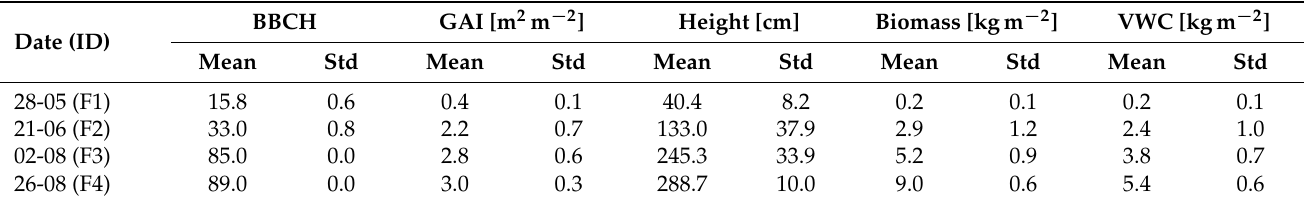
Figure 4. Time series of BBCH, volumetric surface soil moisture, and green area index (GAI) measured in situ in eight maize fields, M1 to M8, during the BELSAR-Campaign. Table 2. Mean and standard deviation of several biophysical variables measured in the eight maize fields during the BELSAR campaign. Height and VWC designate the plant height and the vegetation water content. Dates are in the day-month